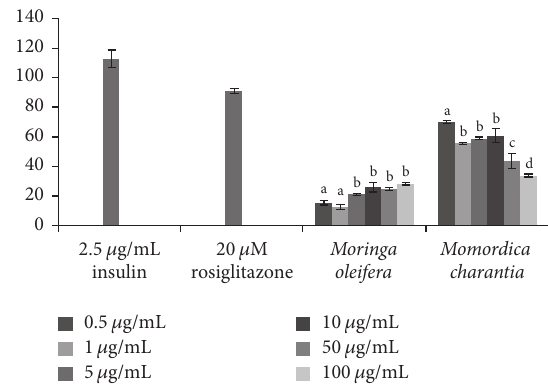
Figure 1: Effect of Insulin and aqueous extracts of Momordica cha- rantia and Moringa oleifera on lipogenesis in 3T3-L1 preadipocyte. 𝑦 -axis indicates the mean percentages of lipogenesis ± SD of triplicate assays compared to control values (cells treated with ultra pure water). Preadipocyte (20000 cells/well, in a 24-well plate) were induced to differentiate with various concentrations of aqueous extracts (5 minutes microwaved) of Momordica charantia and Moringa oleifera prior to Oil Red O quantification assay. Means with different alphabets within an extract are significantly different ( p ≤ 0.05,